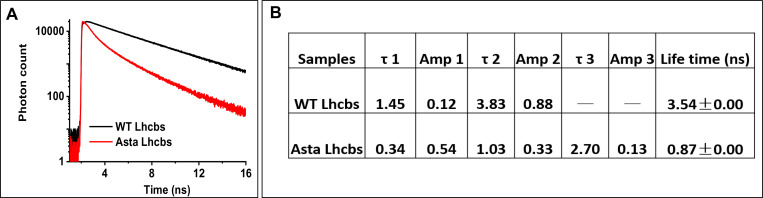
Time-resolved fluorescence decay traces of Lhcb.(A) Fluorescence decay curves of WT Lhcb (black) and Asta-Lhcb (red) upon excitation at 468 nm and detection at 680 nm. (B) Lifetimes of monomeric Lhcs from WT and mutant plants. (Average values ± SD are shown for n = 3 technical replicas.).